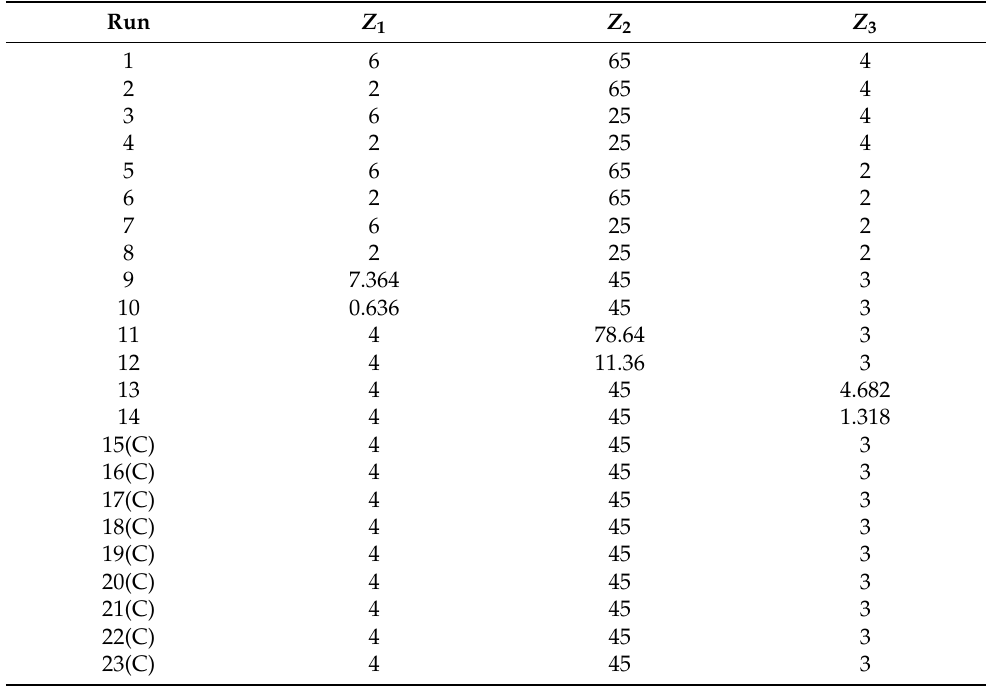
Table 2. Real level combinations matrix of independent variables at different levels using RSM with central composite design. CEC included in the last column is the dependent variable (response).